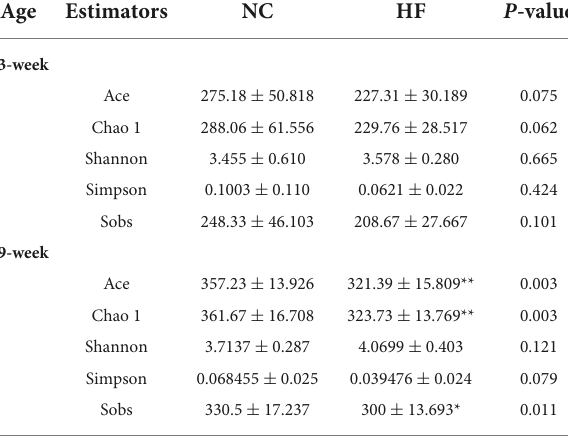
TABLE 1 Alpha diversity of gut microbiota in offspring at weaning and 9 weeks of